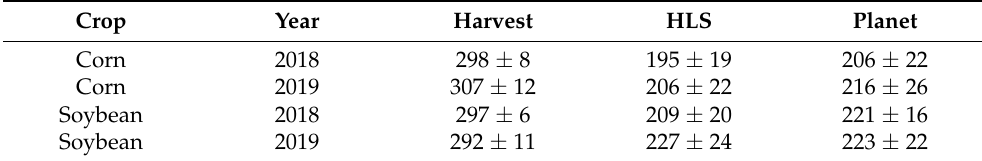
Table 3. Day of year (DOY) for which the maximal R 2 was achieved when correlating satellite-derived SR against crop yields along with crops harvesting dates. HLS: Harmonized Landsat